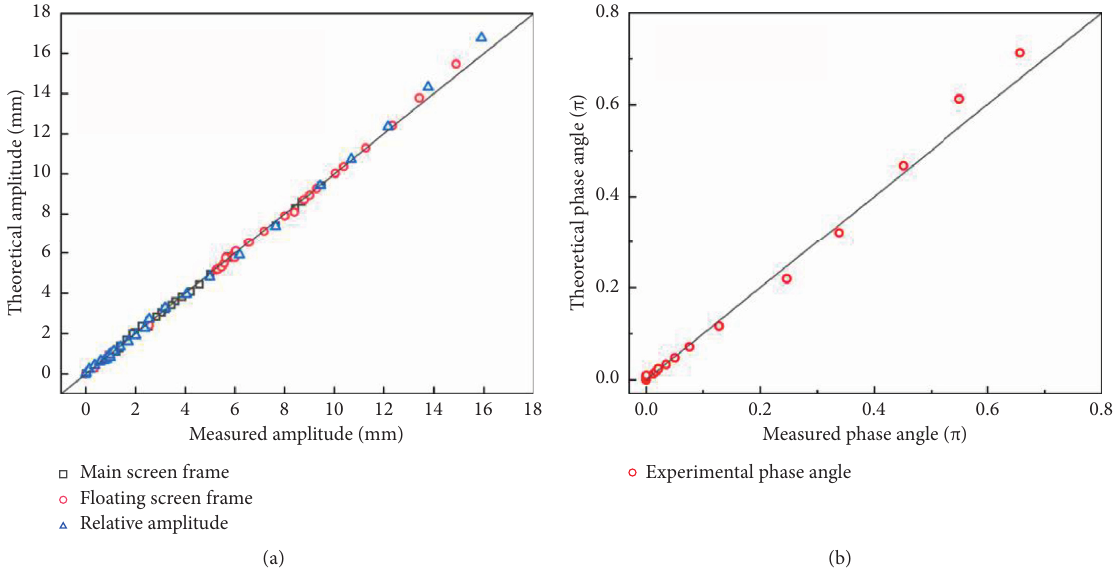
Figure 8: Comparison of the measured data of (a) amplitudes and the (b) phase angle with the theoretical values.